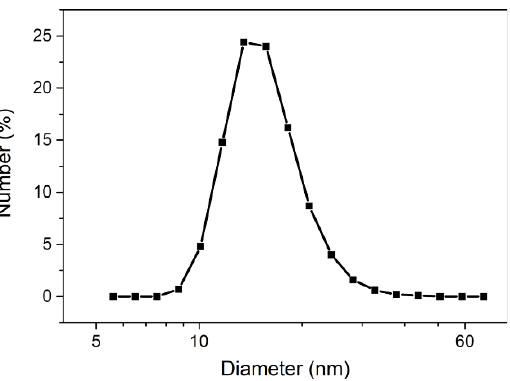
Figure A3. DLS curve in dichloromethane after washing and size selection.